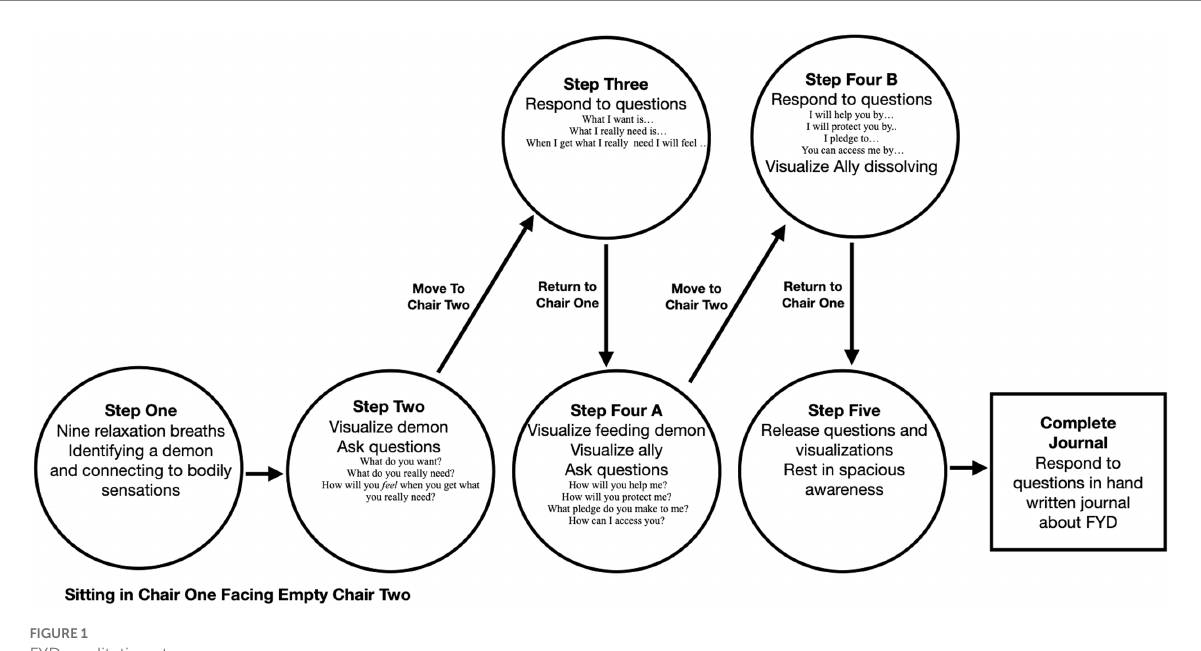
FIGURE 1 FYD meditation